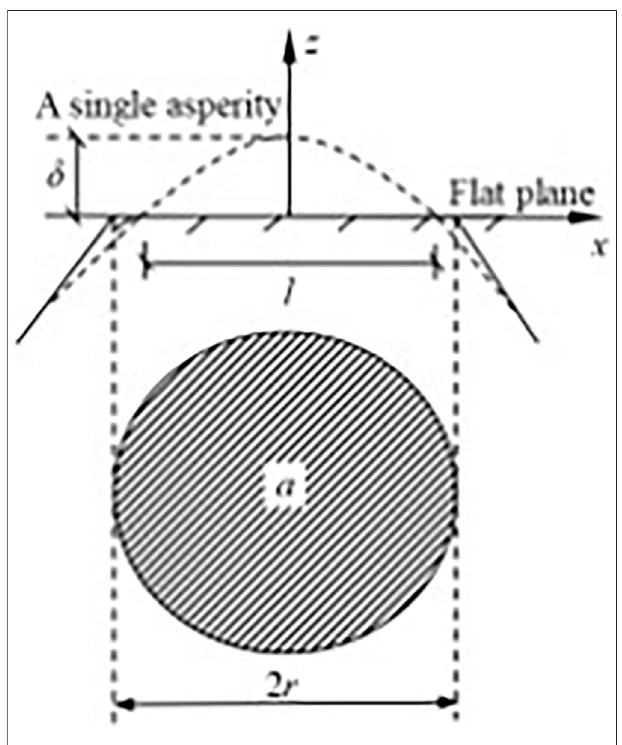
FIGURE 2 | Deformation schematic diagram of a single